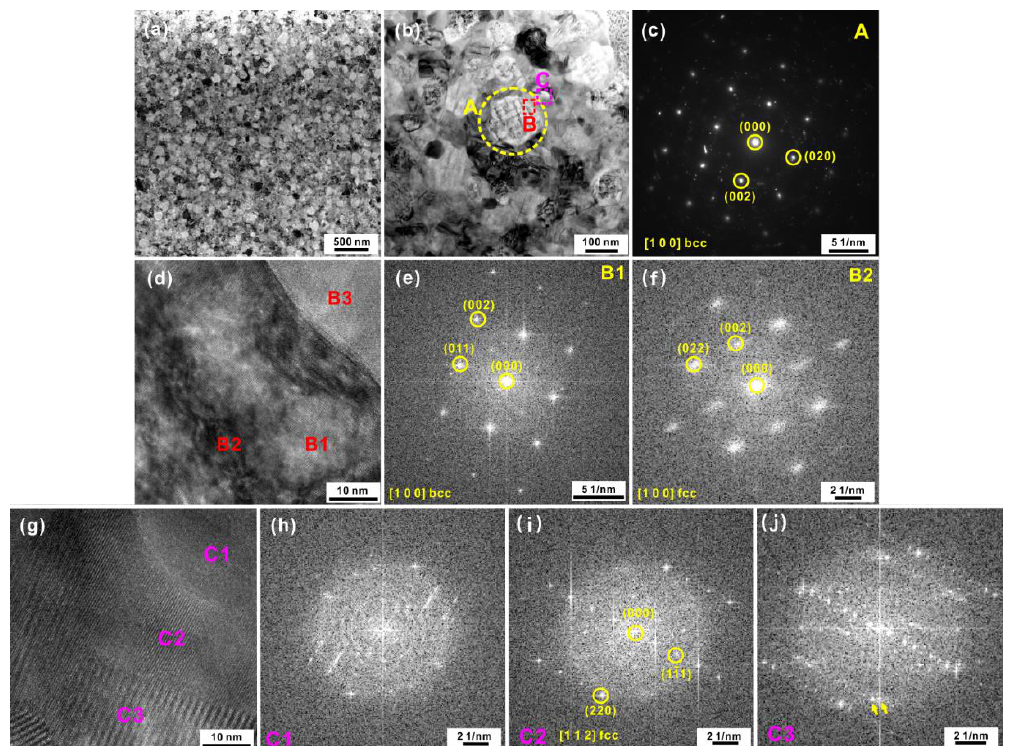
Figure 2. ( a ) Characteristic bright-field TEM image of the AR samples heated to 852 K and ( b ) their local microstructures, ( c ) the SAED pattern of the region A, ( d ) the HRTEM image of the region B, the FFT patterns of the domains ( e ) B1 and ( f ) B2, ( g ) the HRTEM image of the region C, the FFT patterns of the domains ( h ) C1, ( i ) C2, and ( j ) C3.